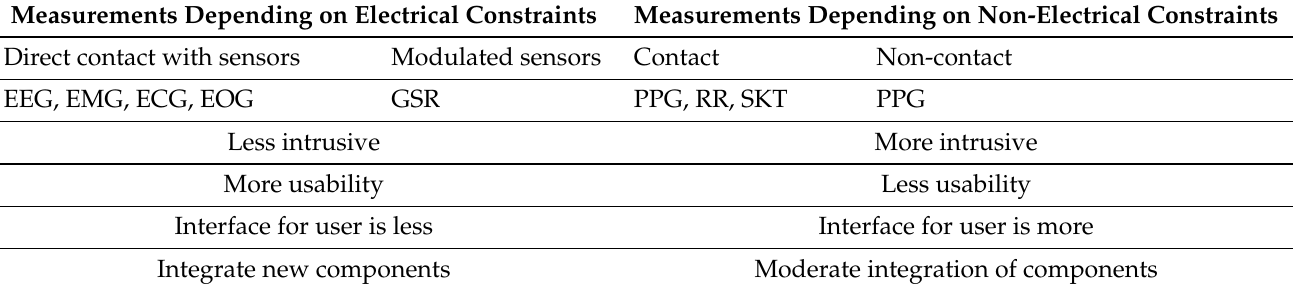
Table 2. Comparison of electrical and non-electrical constraints in human emotion recognition techniques. Measurements Depending on Electrical Constraints Direct contact with